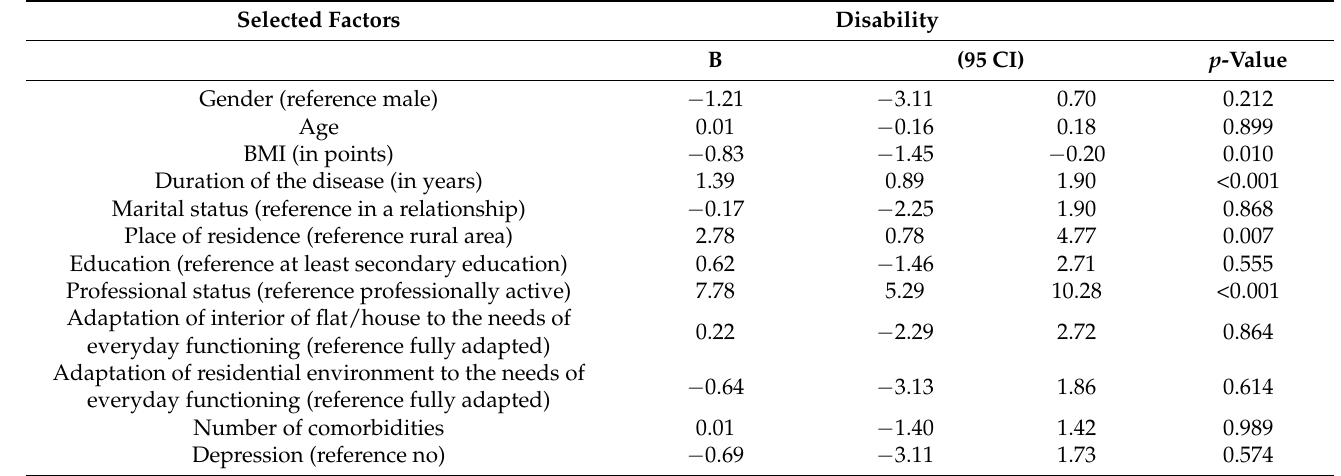
Table 5. Impact of factors related to the level of disability.